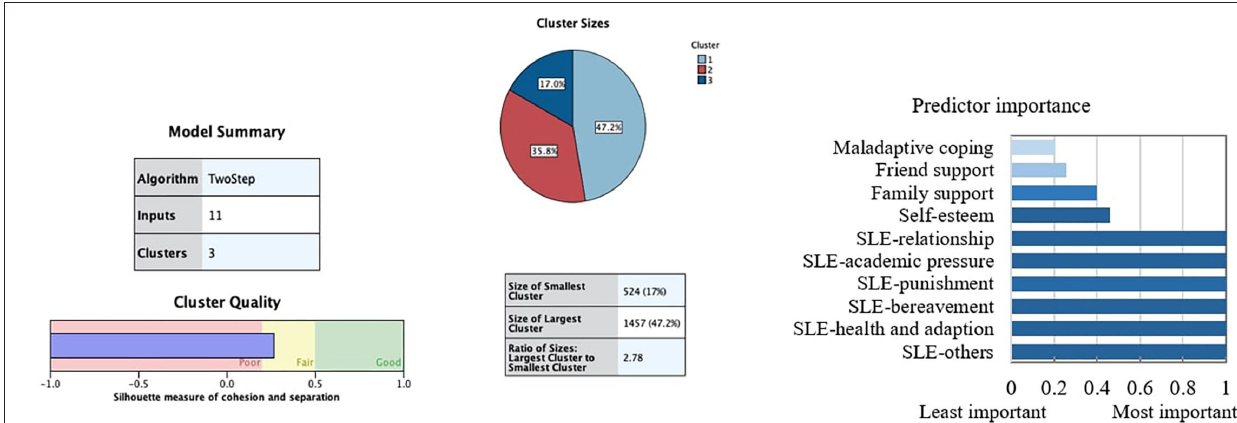
FIGURE 1 | Summary of clustering results. SLE, stressful life events.